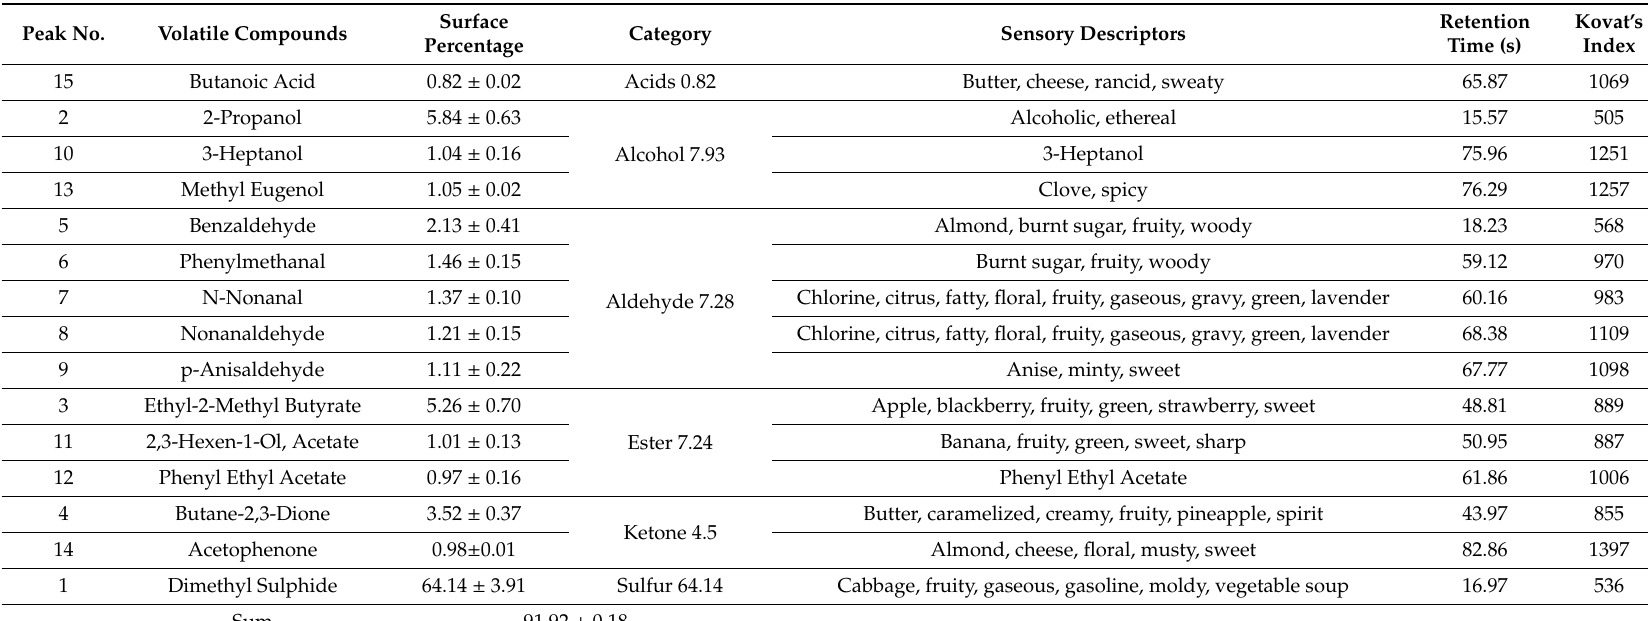
Table 6. Headspace volatile compounds of soybean variety: JTN